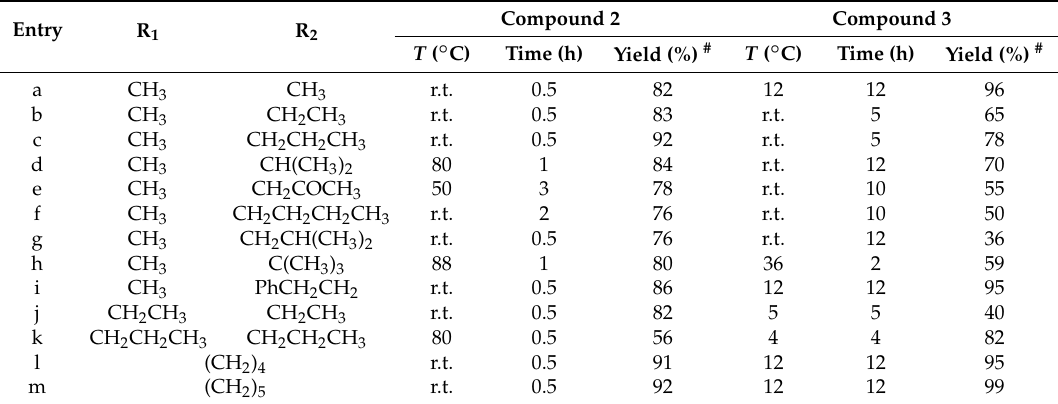
Table 1. Characterization data, reaction condition and yields for products 2 and 3 .